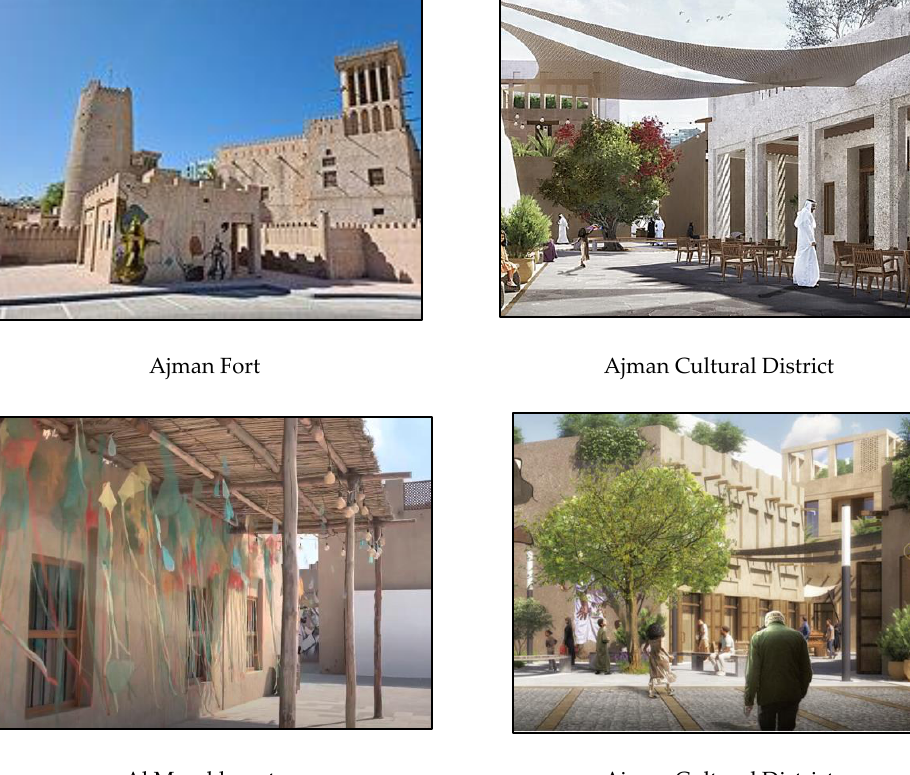
Figure 8. Places in the Ajman heritage area that strength the traditional identity [54,60,67]. In Ajman heritage district, the Architect Verform — who participated in designing fu- ture planning for Ajman — pinpointed the tools required to renew and repair the tradi- tional area. He adopted flexible old architectural vocabulary that already offers a distinc- tive character — covering residential, religious, administrative, and commercial activities.